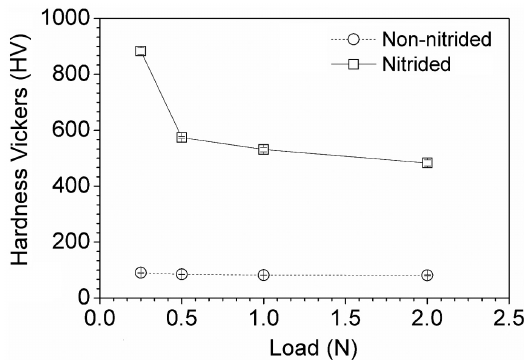
Figure 6. Hardness values of the studied surfaces obtained by using the Vickers indentation technique as a function of the